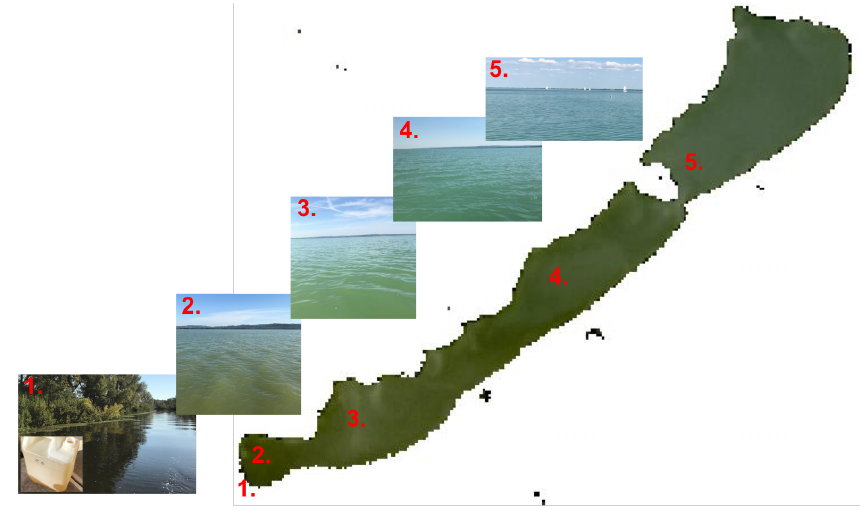
Figure 2. Color gradient in Lake Balaton. The RGB image was acquired by S3 OLCI at 18 August 2017, and the photos were taken at the stations, while the corresponding is situ measurements were